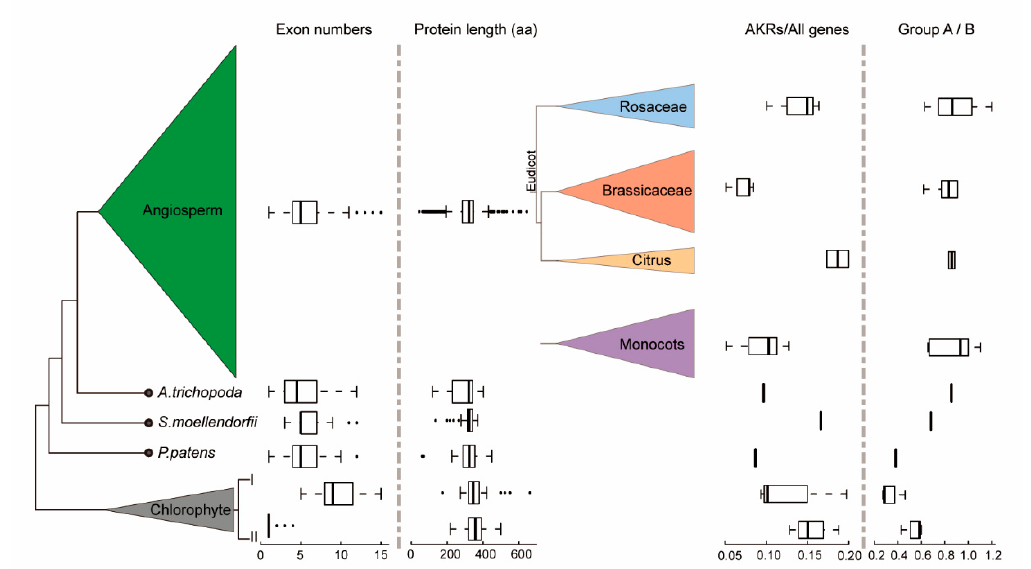
Figure 2. Distribution of the structural characteristics and numerical statistics of the aldo-keto reductases (AKR) gene family in plant species. From left to right: (i) the phylogenetic relationship of higher plants and algae; (ii) boxplots of the exon numbers of AKR genes; (iii) boxplots of the lengths of AKR proteins; (iv) the selected monocots and dicots in angiosperms; (v) boxplots of the percentage of AKR genes occupying all genes; (vi) boxplots of the ratio between group A and B AKR genes.